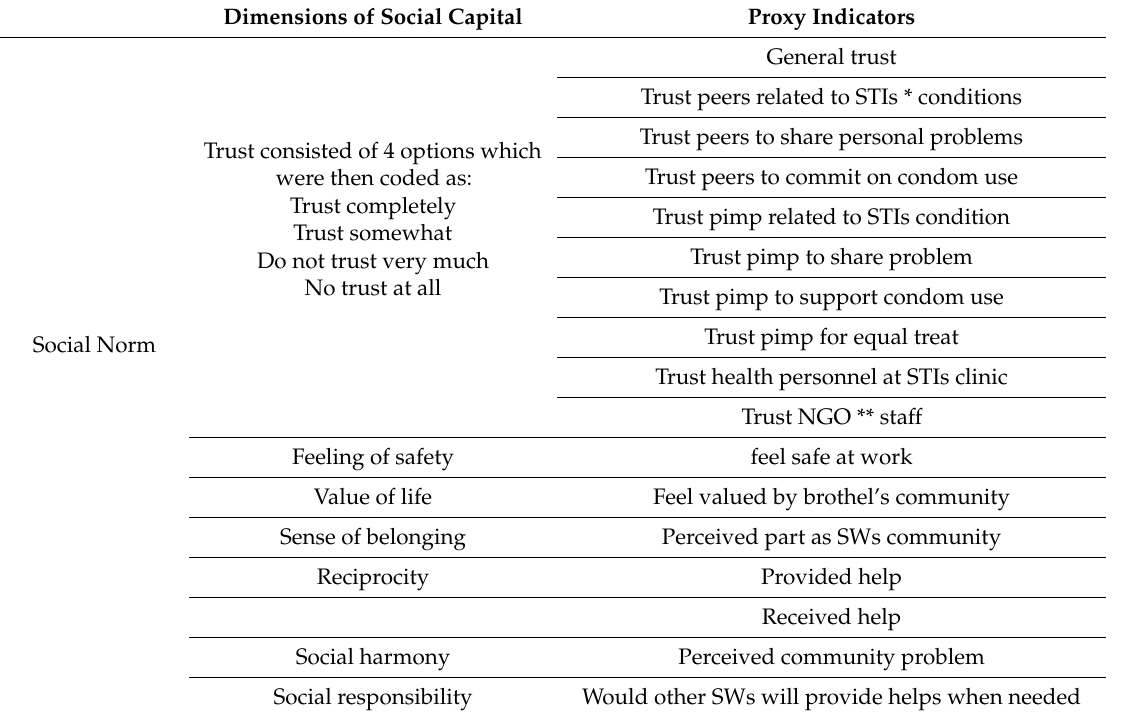
Table 1. The measurement of social capital